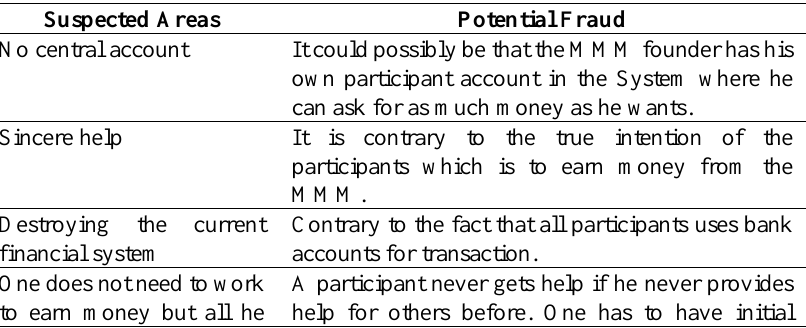
Table 4 Potential Areas for